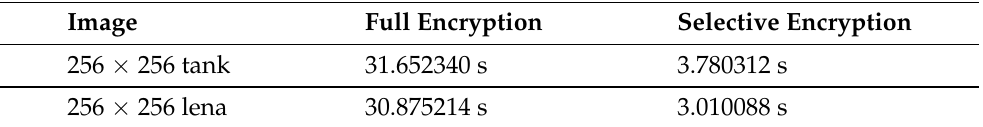
Table 6. Computational complexity of selective encryption against full encryption.